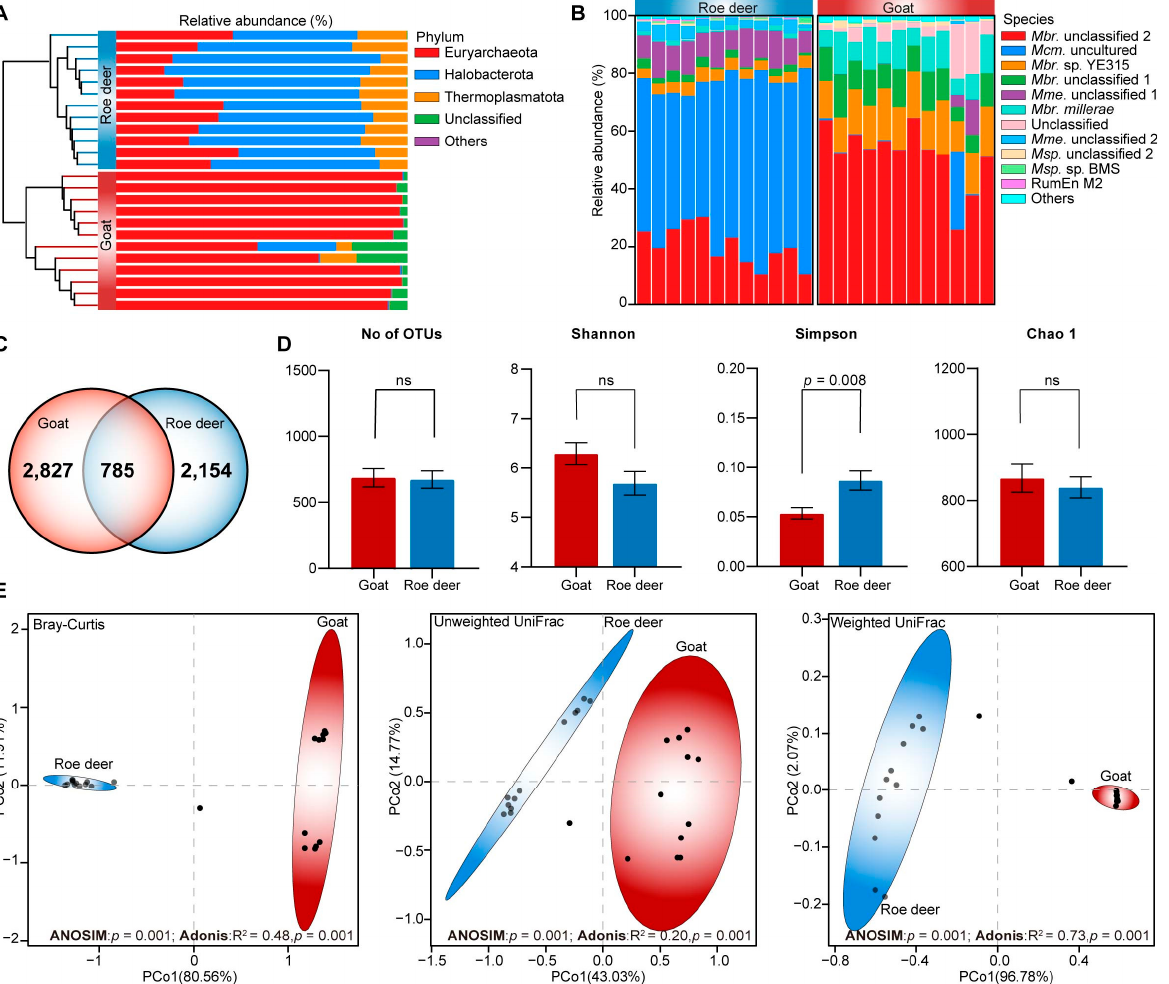
Figure 4. Methanogen community composition in feces of roe deer and goats. ( A ) Clustering the methanogen in the feces of roe deer and goats at the phylum level; ( B ) the methanogen composition in feces of roe deer and goats at the species level; ( C ) the shared and unique OTUs of methanogens between roe deer and goats; ( D ) comparing the methanogen diversity indices in feces between roe deer and goats; ns means no significant differences; ( E ) PCoA results are based on the Bray–Curtis dissimilarity matrix, unweighted UniFrac distance, and weighted UniFrac distance at the OTU level. ANOSIM and Adonis analyses were used for statistical testing of group similarities and differences. The proportion of variation explained for each axis is given after the colon. Samples from roe deer and goats were clustered into blue and red ellipses.